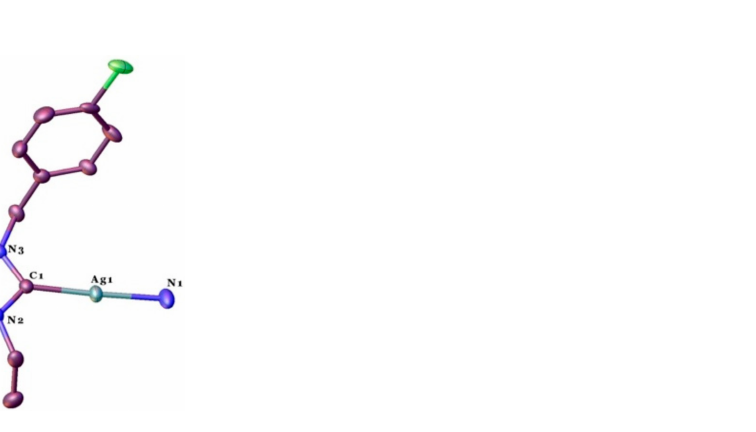
Figure 1. Molecular structure of compound 5 . Thermal ellipsoids are drawn at the 50% level. Hydrogen atoms and the PF 6 − anion have been omitted for clarity.